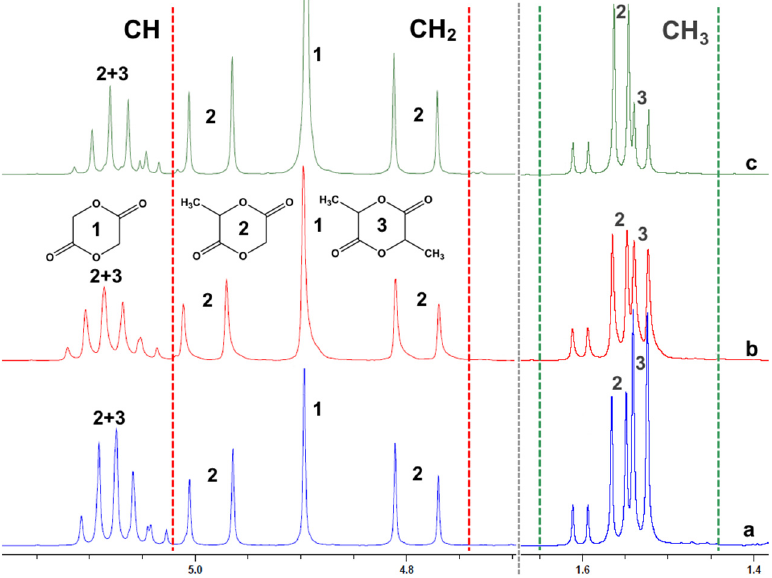
Figure 10. 1 H NMR spectra of main products of GAO:LAO mixture depolymerization: conversion—0.3 ( a ), 0.6 ( b ), 0.75 ( c ).